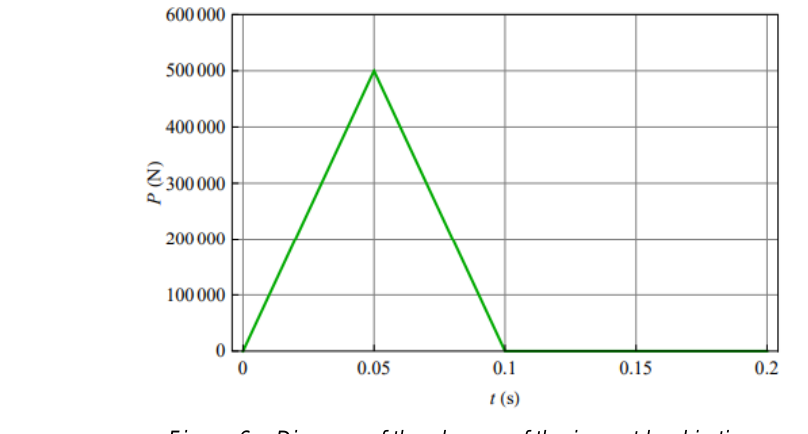
Figure 6 – Diagram of the change of the impact load in time Рис. 6 – График изменения ударной нагрузки во времени Слика 6 – Дијаграм промене ударног оптерећења у